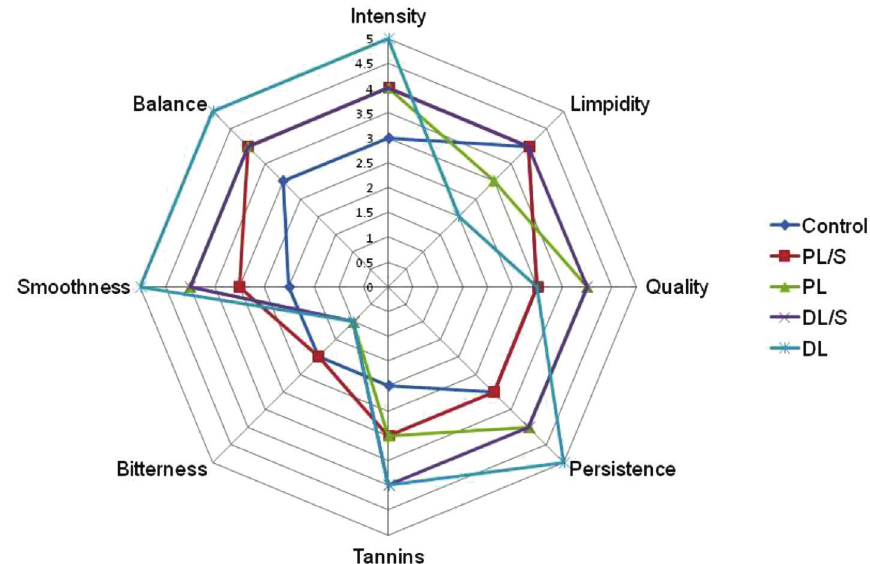
Fig. 6 – Taste aspect of control sample: sulfurized wine in the first year of maturation (PL/S), unsulfurized wine in the first year of maturation (PL), sulfurized wine in the second year of maturation (DL/S), and unsulfurized wine in the first year of maturation